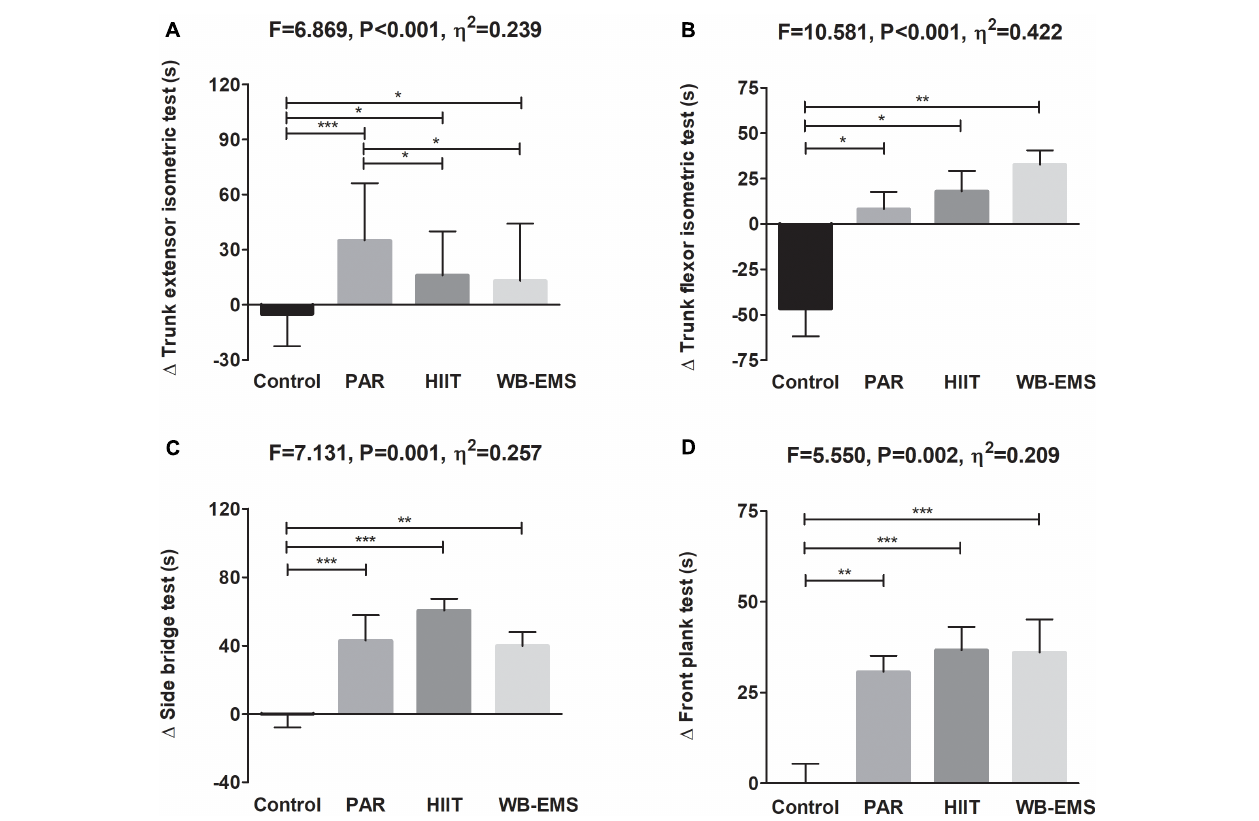
FIGURE 7 | Changes in the trunk extensor isometric test (A) , trunk flexor isometric test (B) , side bridge test (C) , and front plank test (D) after the intervention study among the four groups. Data are shown as means ± standard deviation. Parallel bars indicate significant differences between groups applying an analysis of covariance adjusting by baseline values, with post hoc Bonferroni-corrected t -test ( ∗ P < 0.05, ∗∗ P < 0.01, ∗∗∗ P < 0.001). PAR, physical activity recommendations for adults proposed by the World Health Organization group; HIIT, high intensity interval training group; WB-EMS, whole-body electromyostimulation